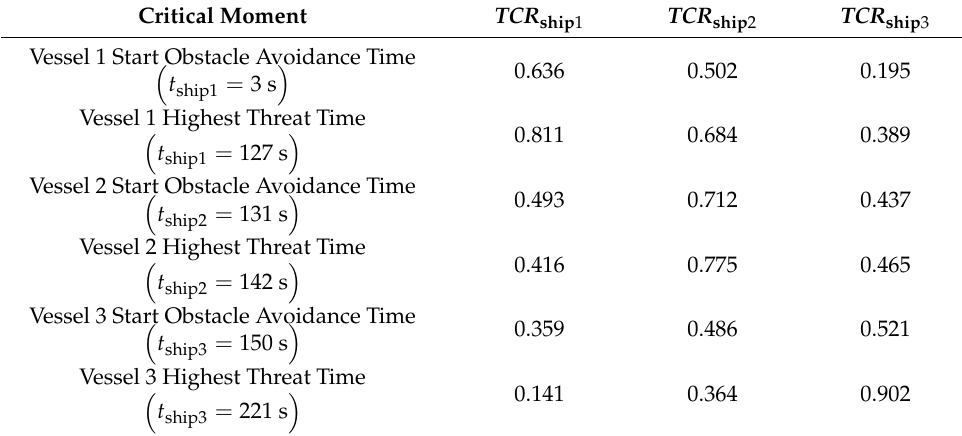
Figure 13d simulates the obstacle avoidance process of the USV in the scenario of multi-vessel encounters. Figure 13a–c show the changes in the relative distance, velocity, and yaw angle of the USV over time during obstacle avoidance. Table 9 shows the real-time evaluation results of the collision threat of the vessel in the USV monitoring area. The of the initial plan and encounters three vessels, which move linearly, during the journey. Table 9 shows the real-time evaluation results for the collision threat of the vessel in the USV monitoring area. Table 9. Critical moment collision threat degree assessment